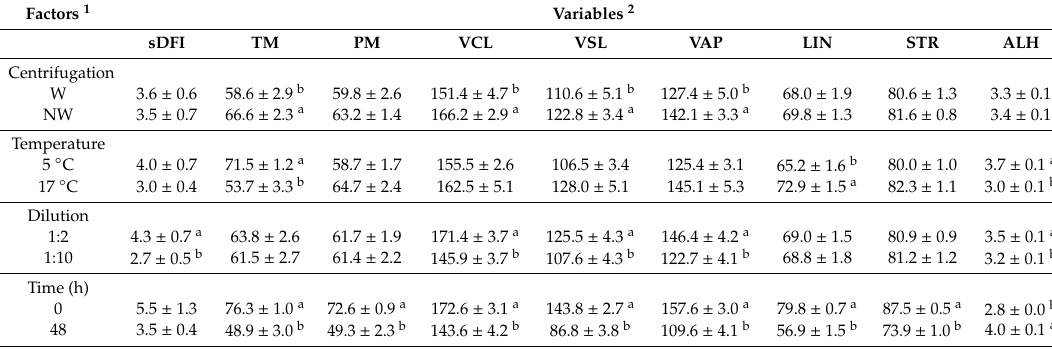
Table 4. E ff ect of temperature, time, sperm washing and concentration on sperm motility and kinetics and DNA fragmentation after liquid storage.